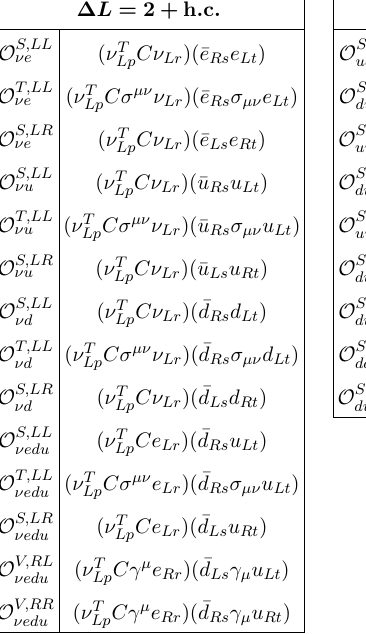
Table 8 . The LEFT dimension-six four-fermion operators that violate baryon and/or lepton num- ber. All operators have Hermitian conjugates. The operator superscripts V , S , T refer to products of vector, scalar, and tensor fermion bilinears, and the additional two labels L or R refer to the chiral projectors in the bilinears. The subscripts p, r, s, t are weak-eigenstate